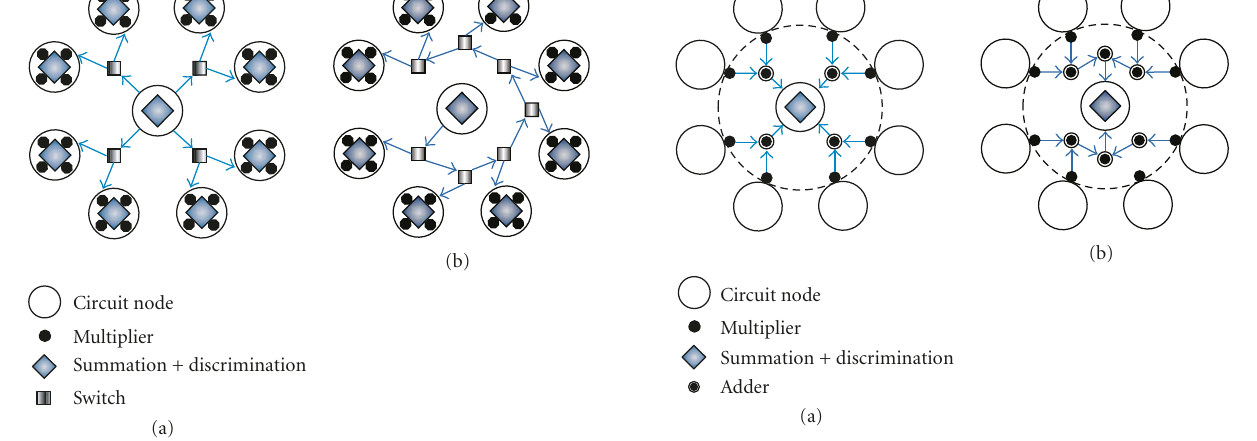
Figure 11: More value routing by multiplexing (a) in space and (b) in time.